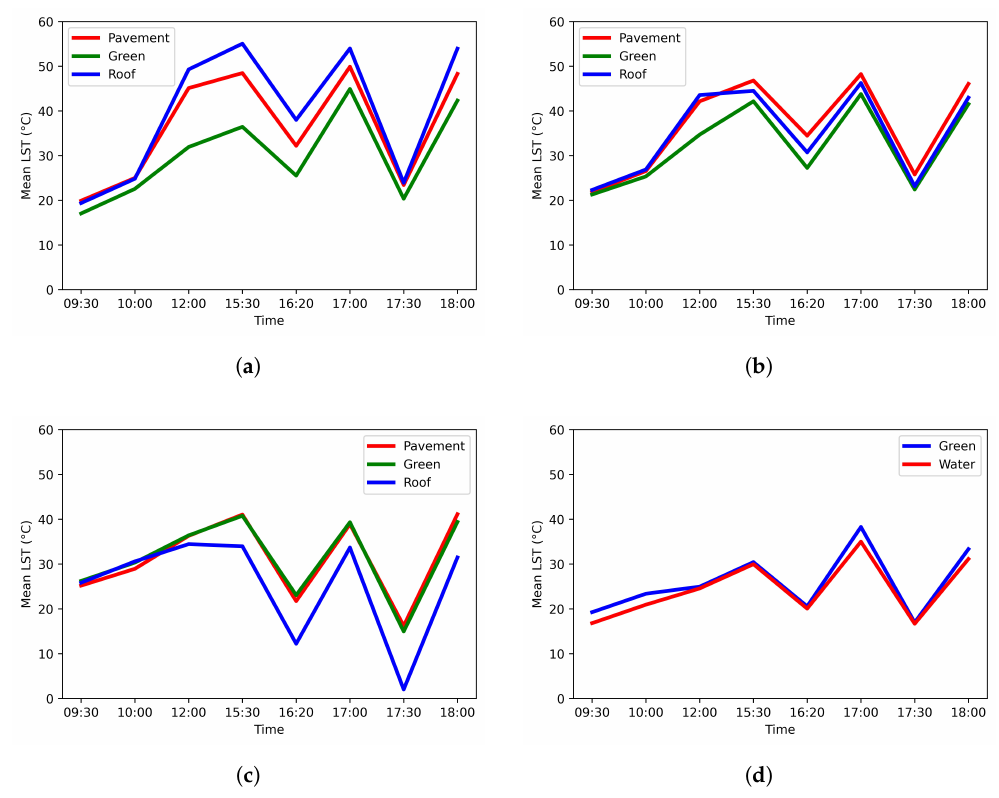
Figure 7. Temporal variation of mean LST for different land cover in each LU. ( a ) Residential High Cost ( b ) Residential Low Cost ( c ) Industrial Area ( d ) Park